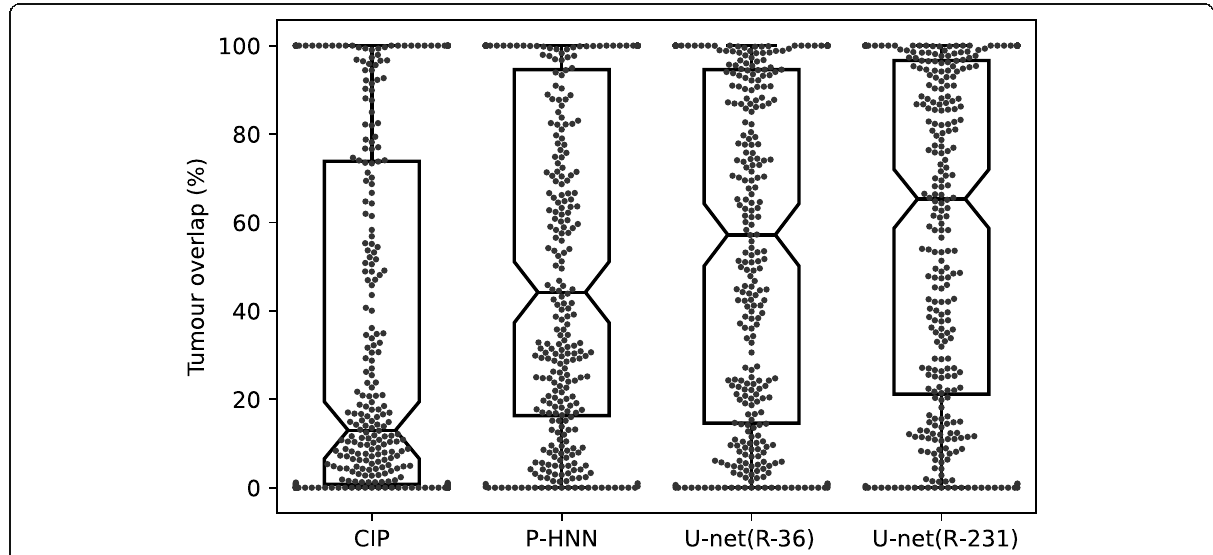
Fig. 4 U-net trained on routine data covered more tumour area compared to reference methods. Box- and swarm plots showing the percentage of tumour volume covered by lung masks that were generated by different methods (318 cases)